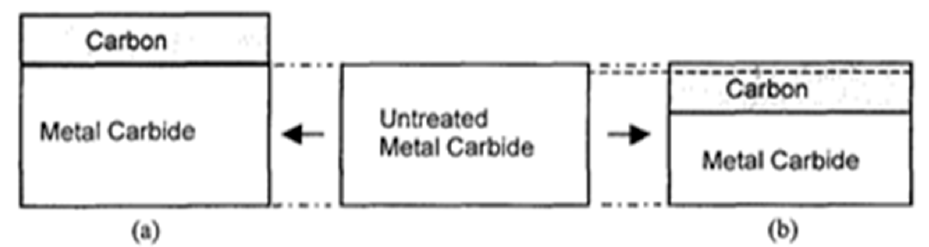
Figure 41. Carbon coating via vapor deposition ( a ) and selective leaching of carbides ( b ). Reprinted with permission from Reference [140]. Copyright 2000 Springer Nature.